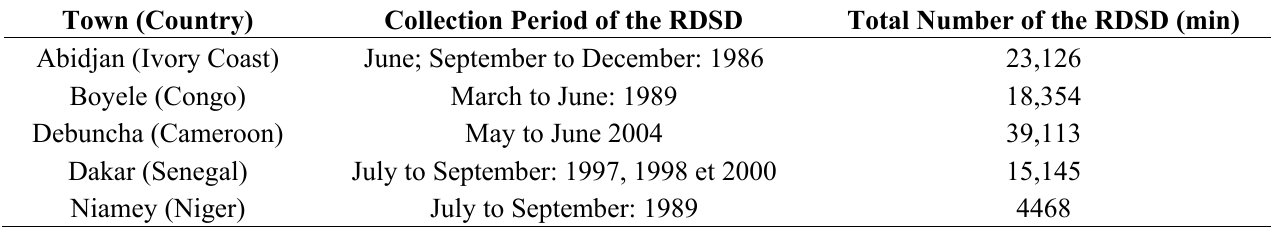
Table 2. Values of the exponent factor p and of the multiplicative factor a the parameter studied ( (cid:1842) = (cid:1853)